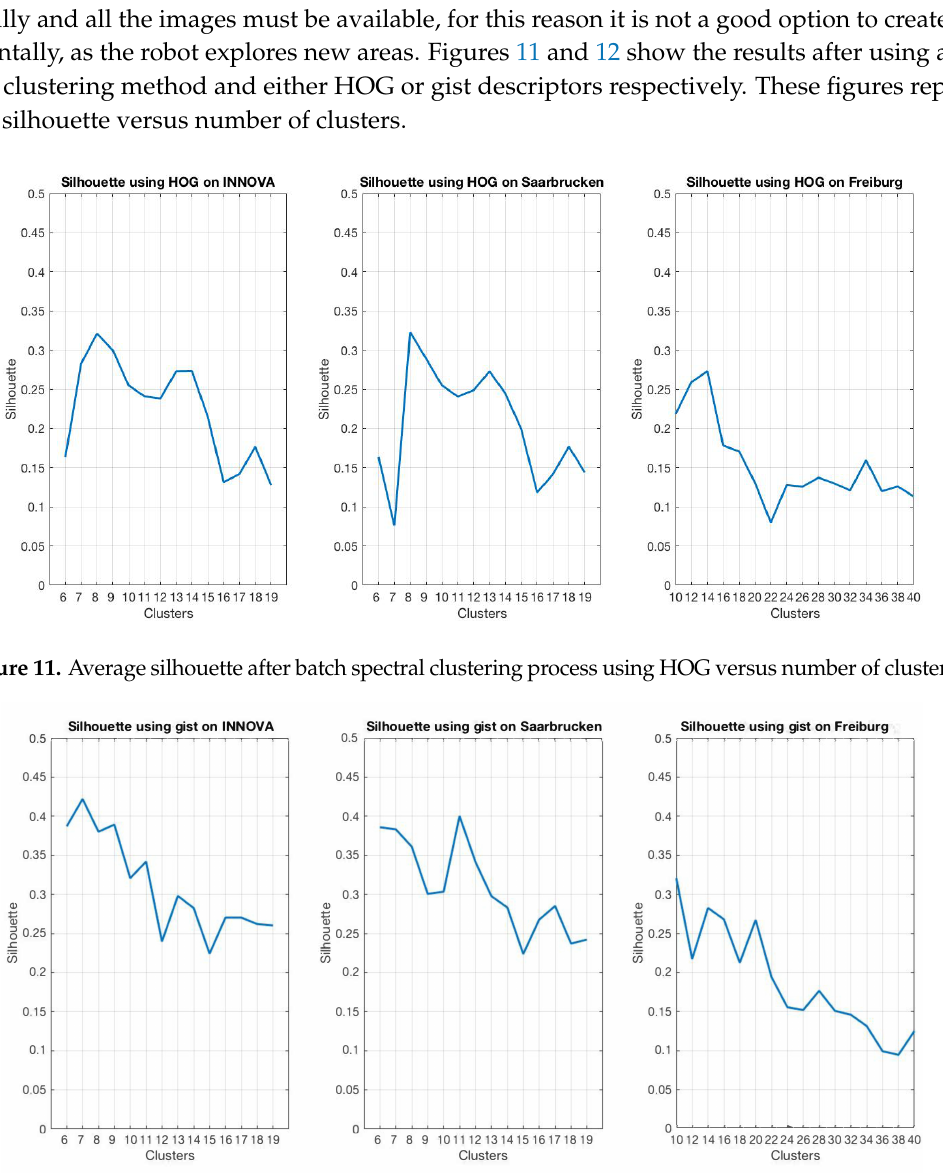
Figure 12. Average silhouette after batch spectral clustering process using gist versus number of